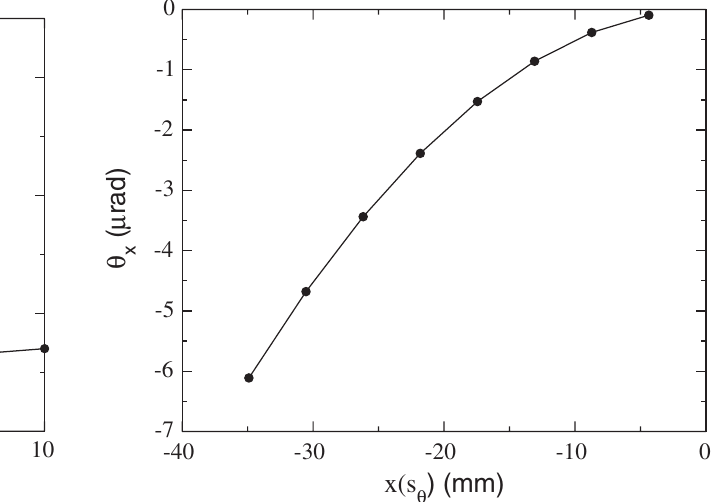
FIG. 4. The error of the method (cid:7) as a function of the gradient error strength, predicting the method error to be less than 0.04% for RHIC gradient errors larger than 10 (cid:1) 3 m (cid:1) 1 .